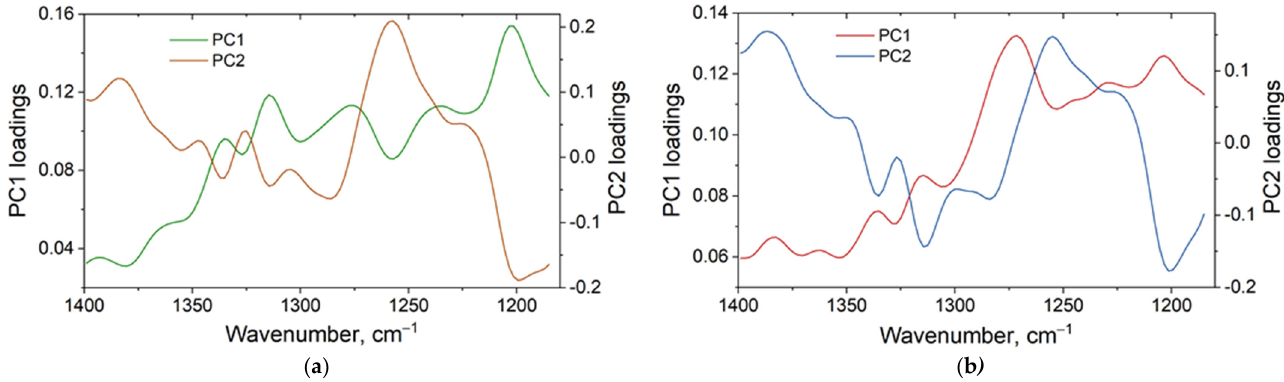
Figure 3. Loading plots performed on infrared spectra in the 1400–1185 cm − 1 region for untreated and ThermoWood ® Norway spruce ( a ) and Scots pine ( b ).